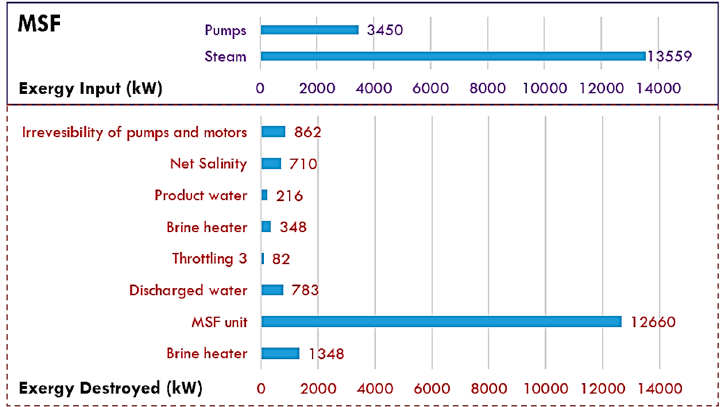
Figure 3. Exergy balance of the Al-jubail MSF plant (data taken from [29]).